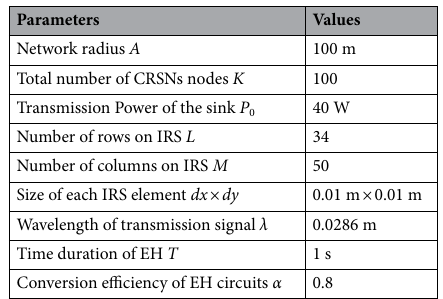
Table 2. Simulation parameter